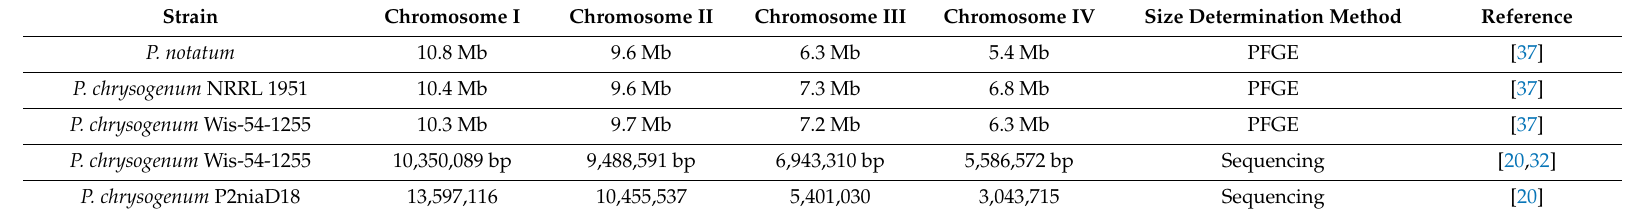
Table 3. Size of individual chromosomes in P. chrysogenum and P. notatum